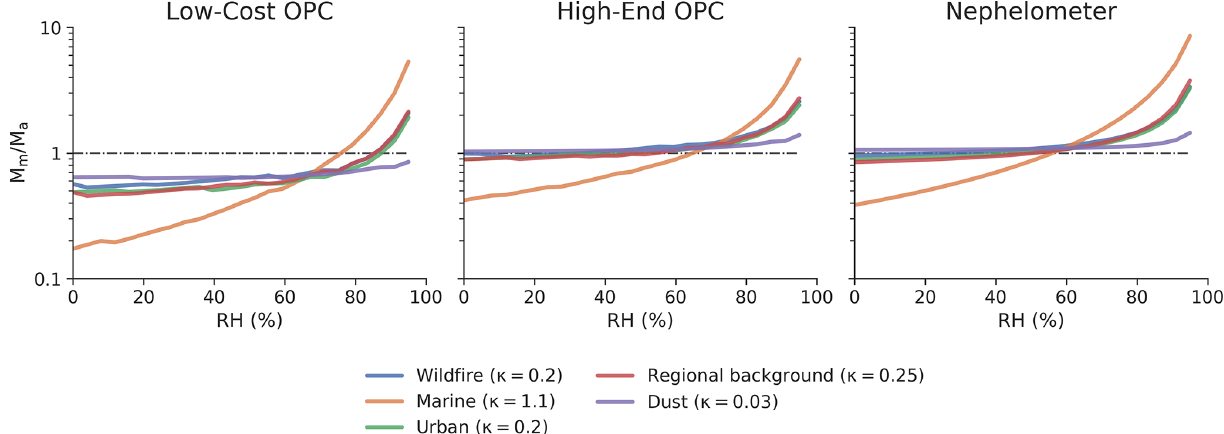
Figure 2. The accuracy in PM 2 . 5 mass loading for a given particle sensor ( M m /M a ) as a function of relative humidity for common aerosol types. All three particle sensors were calibrated with ammonium sulfate (number-weighted geometric mean (GM) = 200nm, geometric standard deviation (GSD) = 1.65). Details on the physical and optical properties of the various aerosols can be found in Table